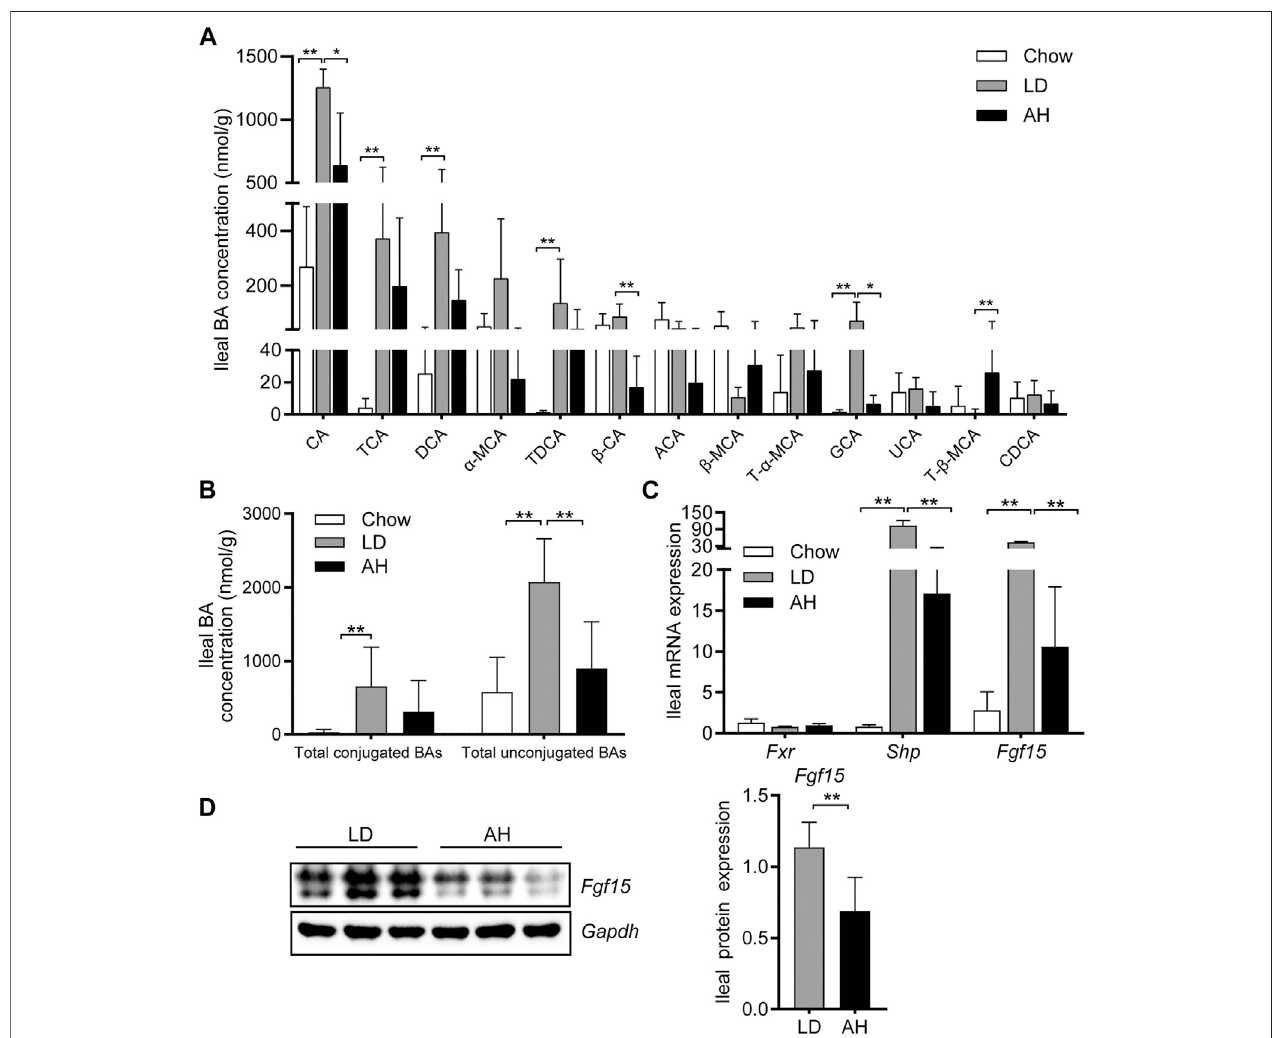
FIGURE 4 | Bile acid (BA) species in the ileum and Fxr – Fgf15 axis. (A) Analyses of BA species ( n (cid:2) 10). Top-13 most abundant BA species are shown. (B) Total conjugatedBAsandunconjugatedBAs( n (cid:2) 10). (C) IlealmRNAexpressionof Fxr , Shp ,and Fgf15 ( n (cid:2) 8). (D) Ilealexpression(leftpanel)andquanti fi cation(rightpanel)of Fgf15 protein ( n (cid:2) 6). Data are the mean ± SD. * p < 0.05, ** p < 0.01. Chow, chow diet; LD, lithogenic diet; AH, high-dose